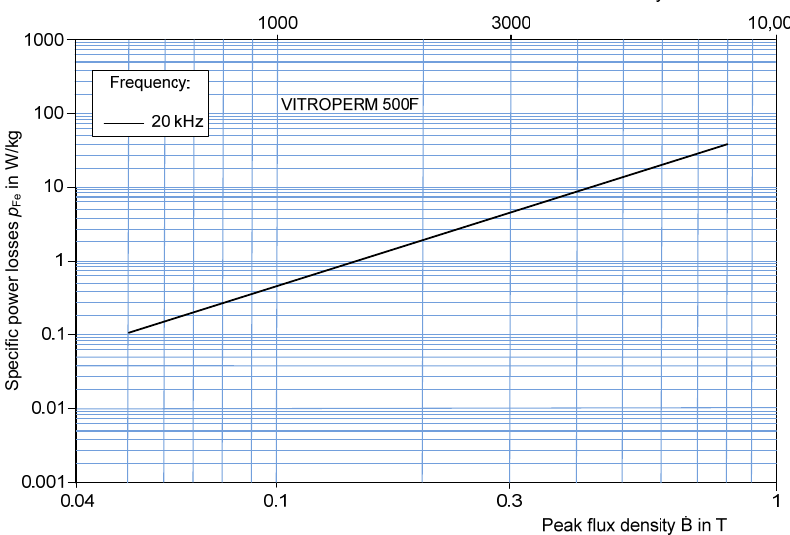
Figure 4. Core losses versus flux density for nanocrystalline materials (20 kHz).